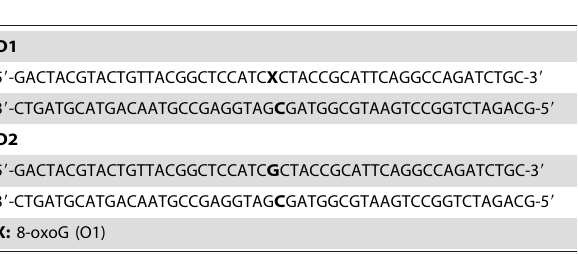
Table 3. Oligonucleotides used in this study.